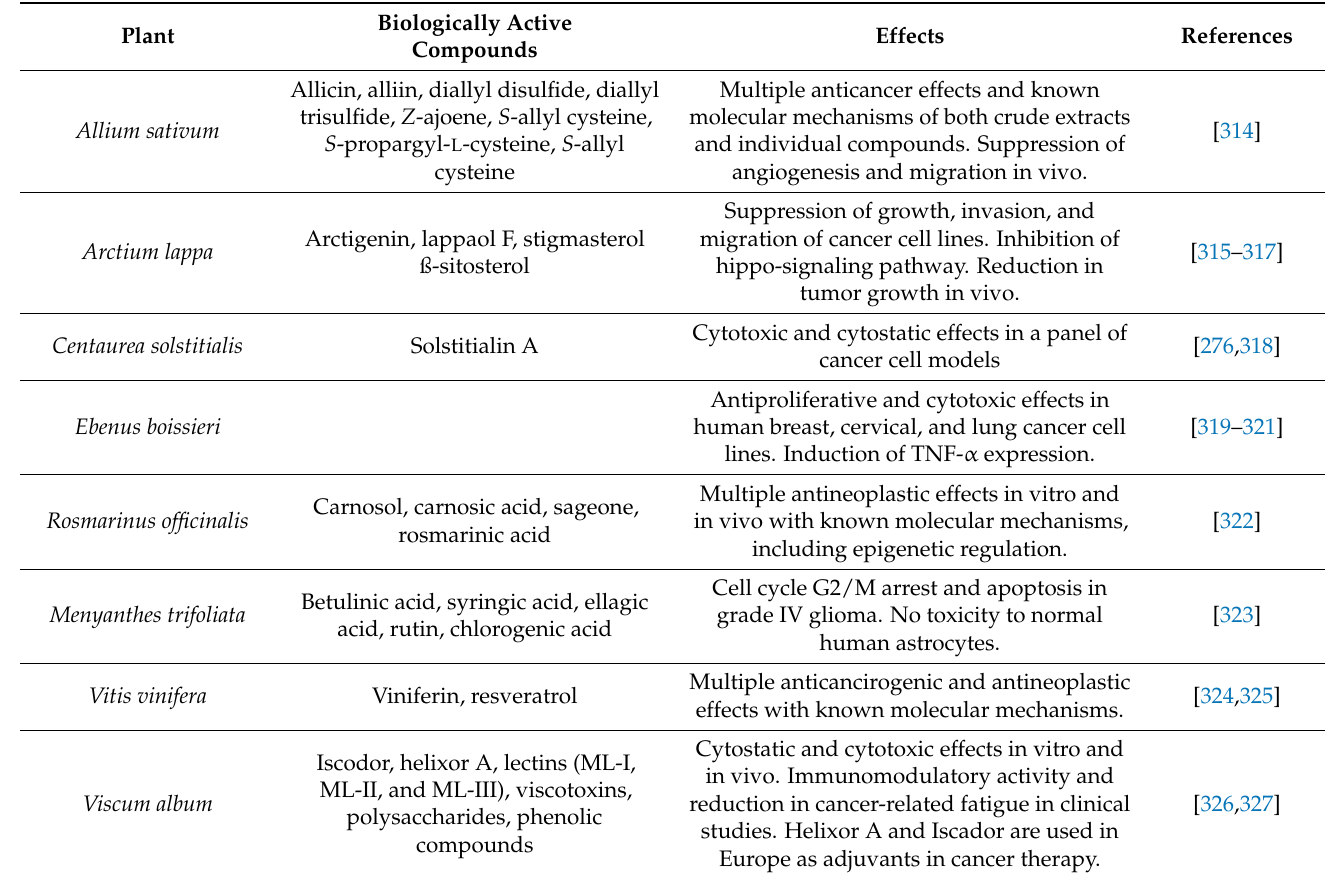
Table 4. Some European plants and their compounds with anti-neoplastic